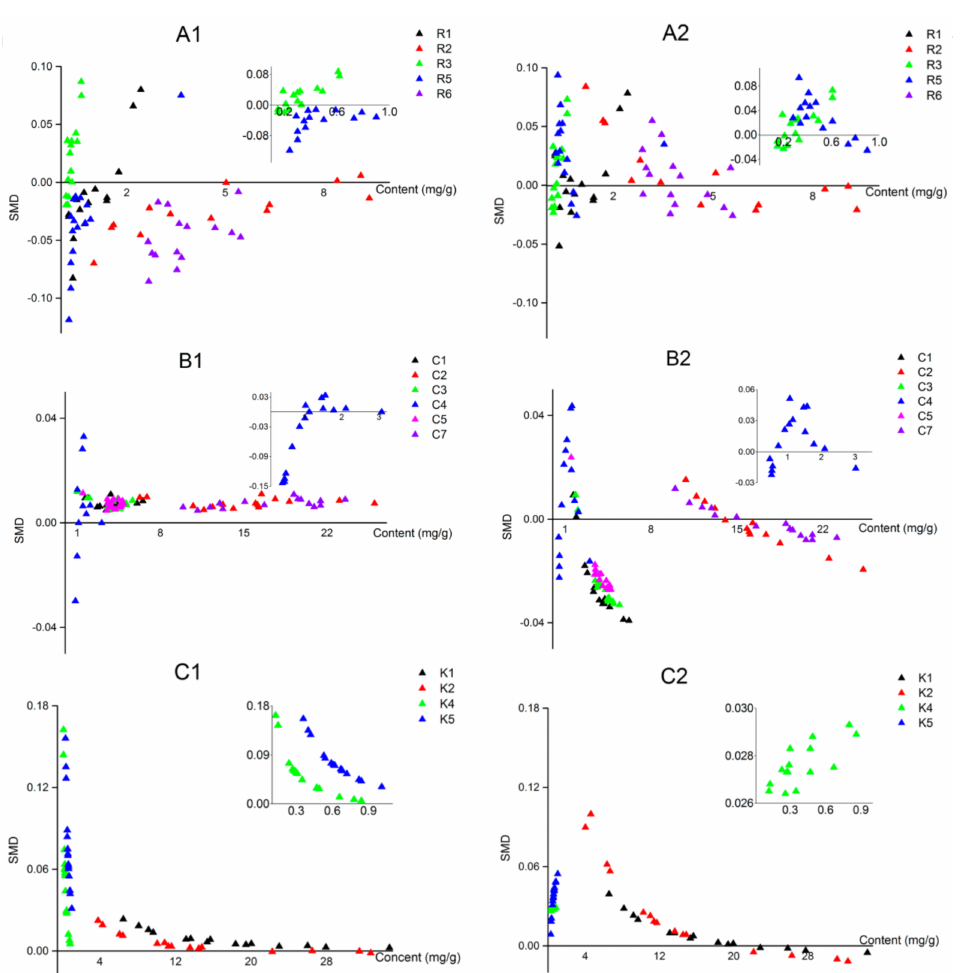
Figure 4. The scatter diagrams that reflect the relationship between standard method differences (SMDs) of fifteen analytes in 15 batches of Ilex kudingcha C. J. Tseng assayed by using LRG-QAMS ( A1 ~ C1 )/AVG-QAMS ( A2 ~ C2 ) method and the content of the 15 analytes (X axis represents the content of the 15 analytes, A: R1~R6 except R4, B: C1~C7 except C6, C: K1~K5 except C3; R4, C6 and K3 as the internal